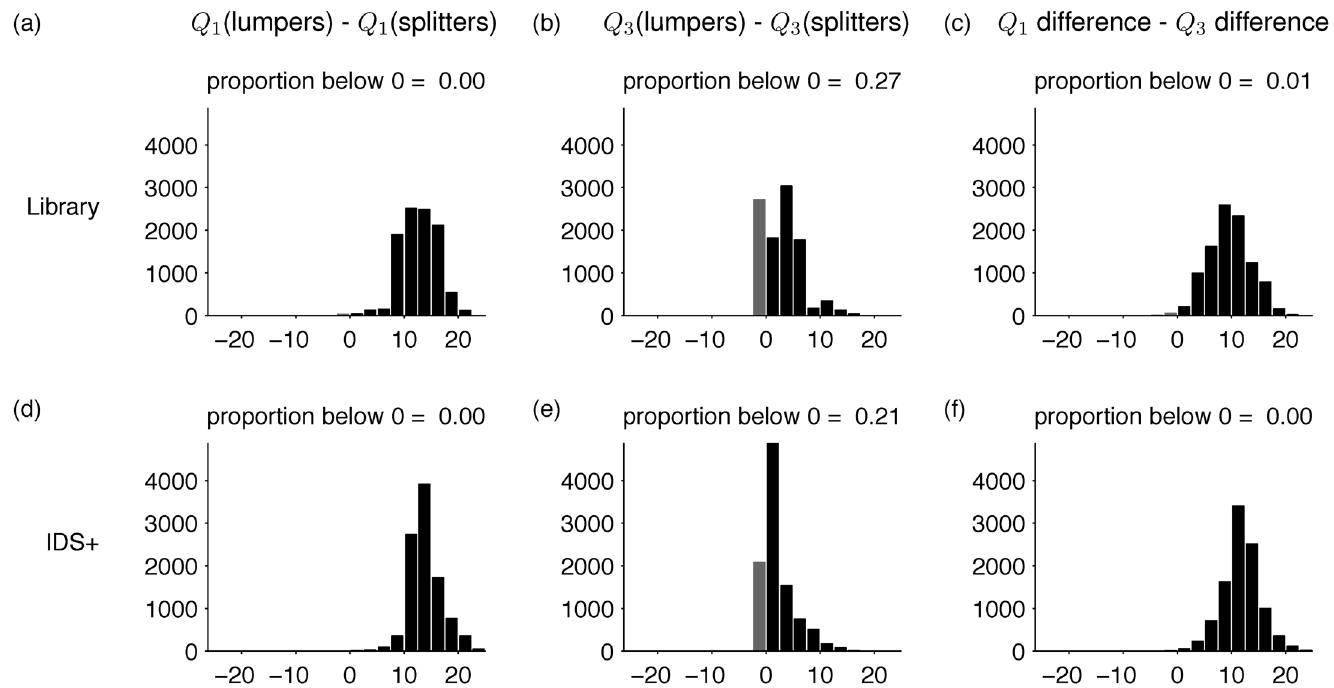
Fig 7. Monte Carlo results. The first column shows that the first (lowest) temperature quartile of a lumper sample is almost always higher than the first quartile of a splitter sample. The second column shows that the differences between third quartiles of the samples are less skewed. The third column confirms that differences between the first quartiles are greater than differences between the third quartiles. Results for the library and IDS+ datasets are shown in the first and second rows respectively. The x axis in each plot shows differences in degrees Celsius, and the y axis shows number of